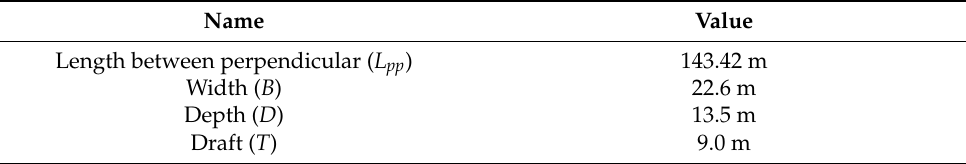
Figure 4. Ship model of EEDI type of bow form. ( a ) Front view, ( b ) Top view and side view. Table 5. Ship parameters of EEDI type of bow form. Table 5. Ship parameters of EEDI type of bow form.